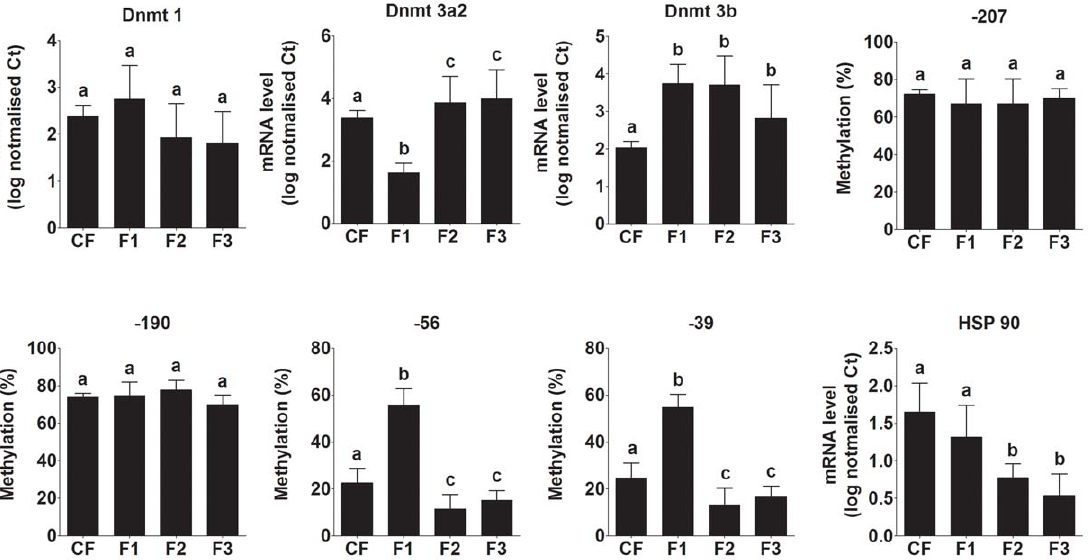
Figure 7. Hepatic DNA methyltransferase expression and Dnmt3a2 promoter methylation, and embryo heat shock protein 90 expression. Dnmt 1, Dnmt 3a2 and Dnmt3b mRNA expression in the liver of non-pregnant adult offspring on postnatal day 70. Methylation of individual CpGs in the Dnmt 3a2 promoter in adult offspring. HPS 90 mRNA expression in post-conception day 8 gastrulating embryos. Values are mean 6 SD, n=5 to 7 samples per group. Values with different letters are significantly different (P , 0.05).